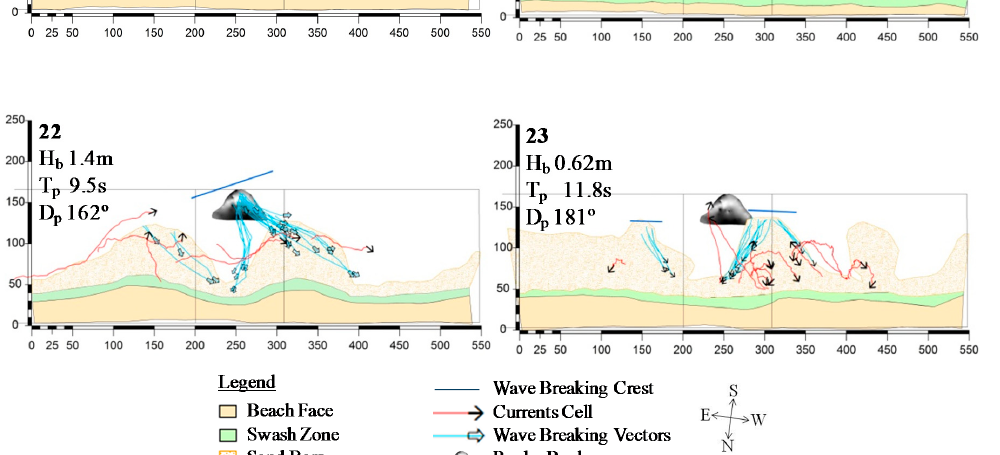
Figure 6. Bidimensional response of morphological (beach face, swash zone, and sand bars) and hydrodynamic features (currents cell tracked and wave breaking vector tracked) in the Reserva Beach system. The configurations of these nine cases were grouped due the erosion morphological feature in the lee of the rocky bank. The onshore sand bars depth is − 1.5 m, which is relative to the mean sea level for each day. The wave data parameters (H b , T p and D p ) during each case are also indicated.